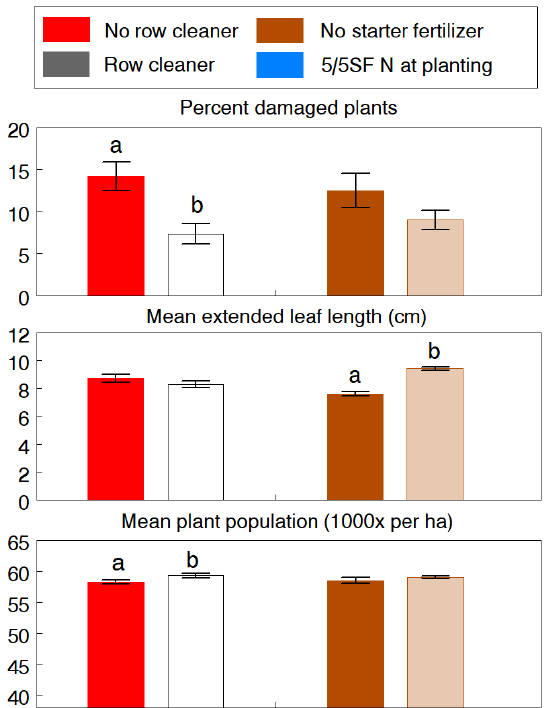
Figure 1. WREC experiment (1992). Effects of using row cleaner and starter fertilizer practices at planting on damage caused of the gray garden slug, Deroceras reticulatum , and on the seedling growth and population in no ‐ tillage corn. The 5/5SF treatment was 30 kg N/ha of 34 ‐ 0 ‐ 0 applied as a deep ‐ band 5 cm to the side and 5 cm below the seed. Pairs of means (±SEM) of each main effect with different letters are significantly different at the 5% probability level.